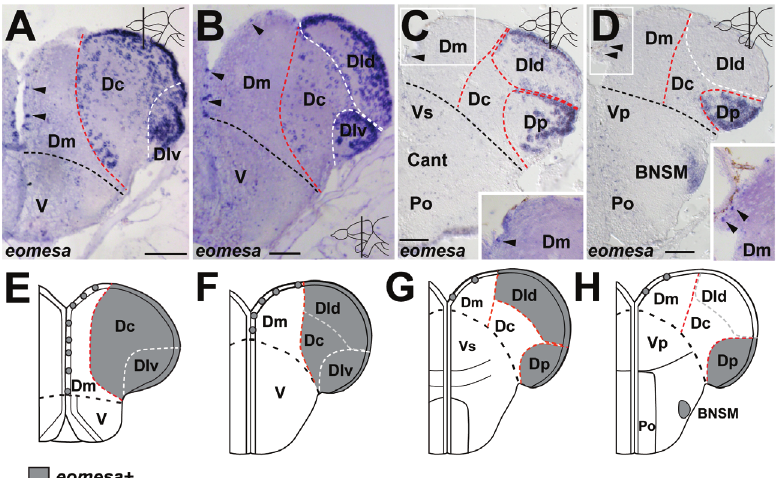
Figure 1. Expression of eomesa in the pallium. A . In the rostral telencephalic, eomesa expression is found in the ventricular zone (vz) of Dm (arrowheads) and in the vz and neuronal layer (nl) of Dc and Dlv. B . At mid-telencephalic levels, eomesa expression is present in the vz of Dm (arrowheads), in the nl of Dc and in the vz and nl of Dld and Dlv. C . At the anterior commissure (Cant), eomesa expression is present in the vz of Dm (arrowhead) and in the vz and nl of Dld and Dp. Inset shows close-up of vz of Dm D . Caudal to Cant, eomesa expression is present in the vz of Dm (arrowhead), in the vz and nl of Dp and in BNSM. Inset shows close-up of vz of Dm E .– H . Summary of the expression pattern of eomesa at rostral ( E .), mid-telencephalic ( F .), commissural ( G .) and postcommissural levels ( H .). A .– D . Brightfield images of cross-sections at the levels indicated through the telencephalon. Red dashed line indicates subdivisions based on the current marker. White dashed line indicates subdivisions based on other markers. The black dashed line indicates the boundary between D and V. Scale bars = 50µm in A – D .